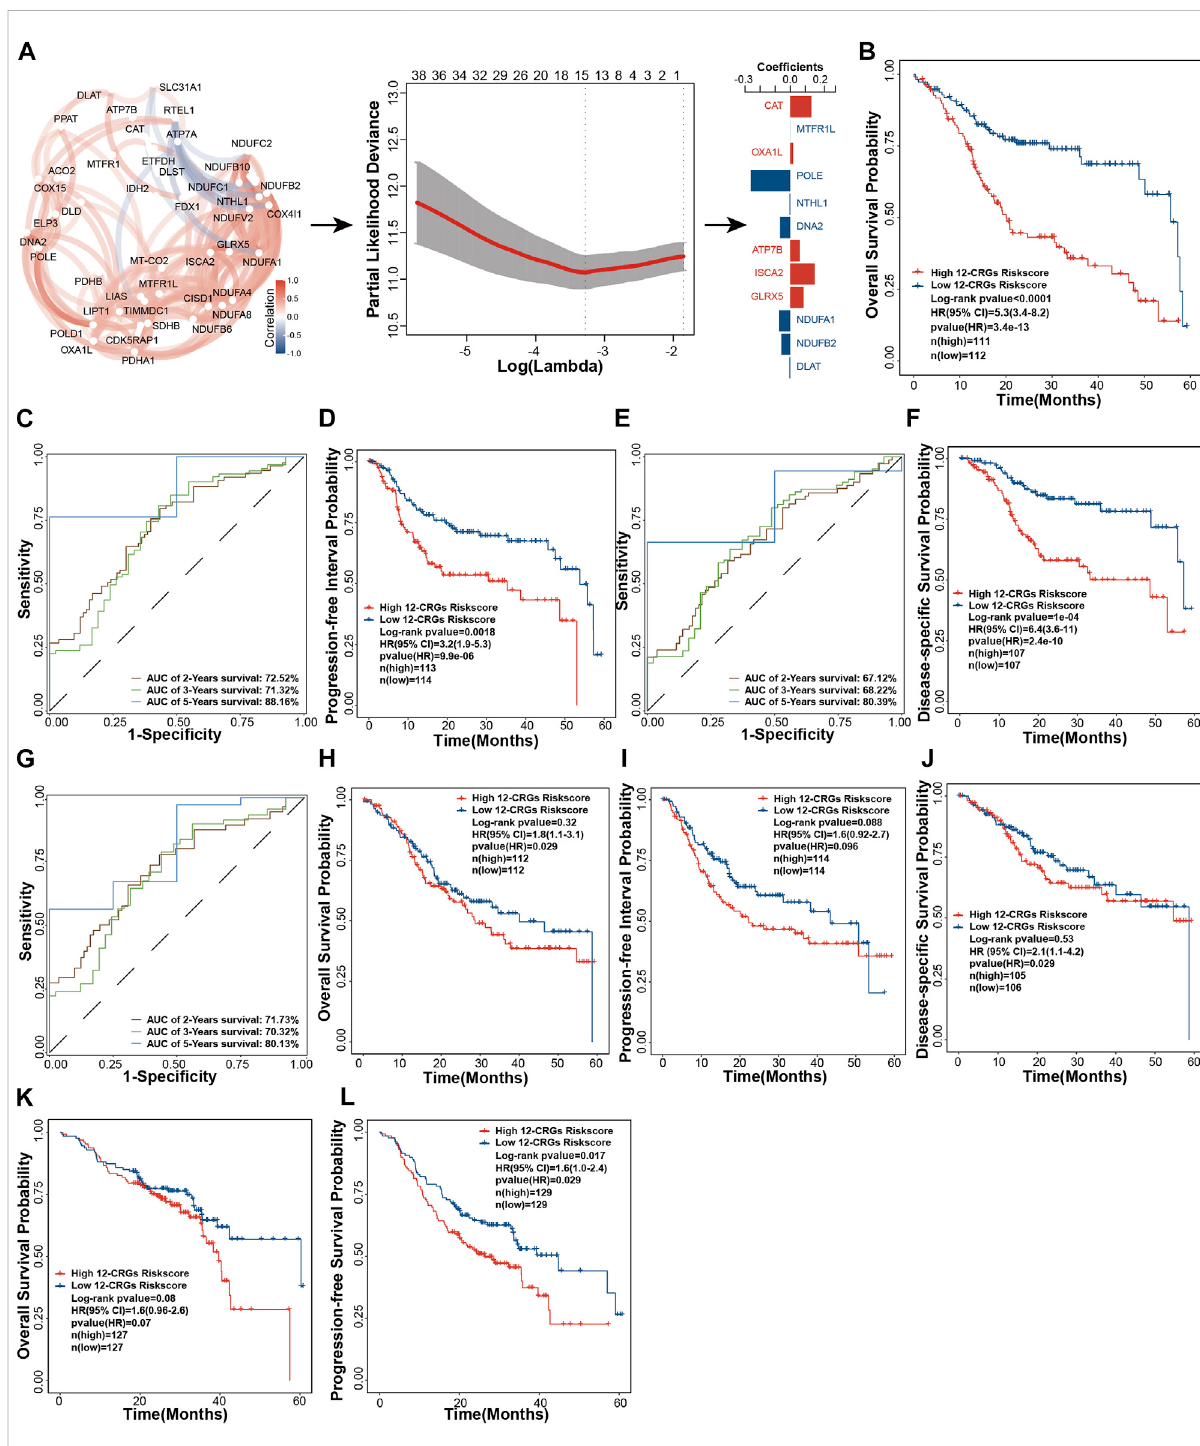
FIGURE 5 Construction and validation of 12-CRGs signature for OS prediction of HNSC (A) Schematic diagram of 12-CRGs signature construction (B) Kaplan-Meier curve showing the OS predicted by the 12-CRGs signature over 5 years (C) AUC values of the time-dependent ROC curves showing thepredictedabilityofthe12-CRGssignatureforOSin2-,3-and5-year (D) Kaplan-MeiercurveshowingthePPIpredictedbythe12-CRGssignature over 5 years (E) AUC values of the time-dependent ROC curves showing the predicted ability of the 12-CRGs signature for PPI in 2-, 3- and 5- year (F) Kaplan-Meier curve showing the DSS predicted by the 12-CRGs signature over 5 years (G) AUC values of the time-dependent ROC curves showing thepredicted ability of the12-CRGs signature for DSSin 2-,3- and 5-year (H – J) Kaplan-Meier curveof OS (H) , PPI (I) and DSS (J) predicted by 12-CRGs signature over 5 years in TCGA-second cohort (K,L) Kaplan-Meier curve of OS (K) and progression-free survival (L) predicted by 12- CRGs signature over 5 years in GSE65858